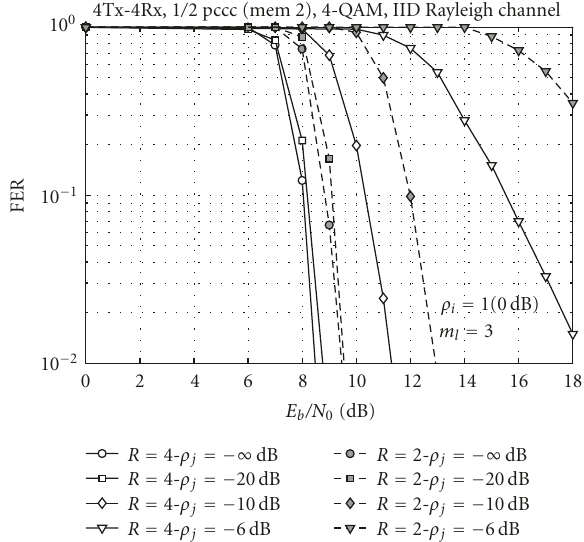
Figure 15: FER for SAIC-DID in the presence of a weak interferer. ρ j represents the path loss of the weak